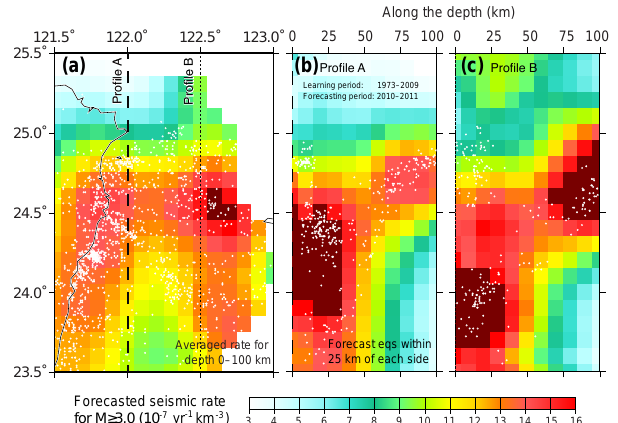
Figure 2. (a) A map view and (b–c) profiles of the forecasted seis- micity rate for M ≥ 3.0 modelled by the epicentre-smoothing ker- nel function. White dots denote the earthquakes from 2010 to 2011. Earthquakes within 25km of each side of the profiles are